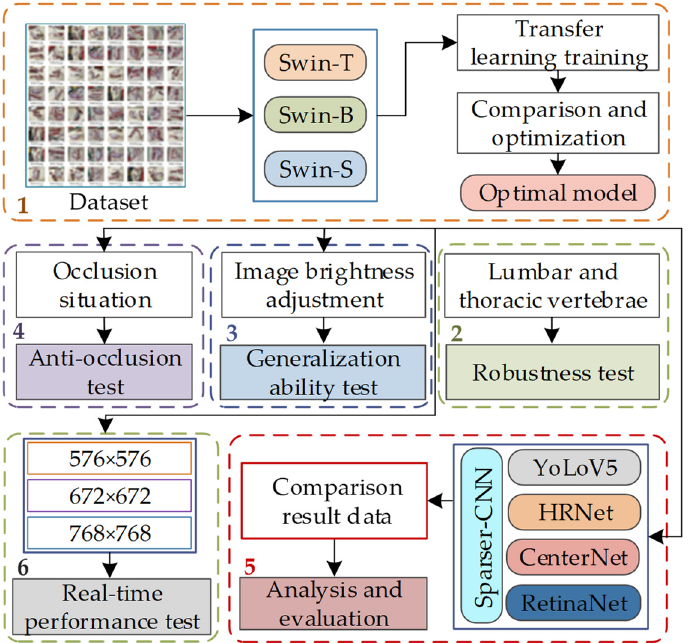
Figure 7. Test flow of classification and detection of mutton multi-part based on Swin-Transformer. Note: 1 is the optimal model acquisition experiment; 2 is the robustness test; 3 is the generalization ability test; 4 is the occlusion resistance test; 5 is the performance comparison experiment; 6 is the real-time performance test.